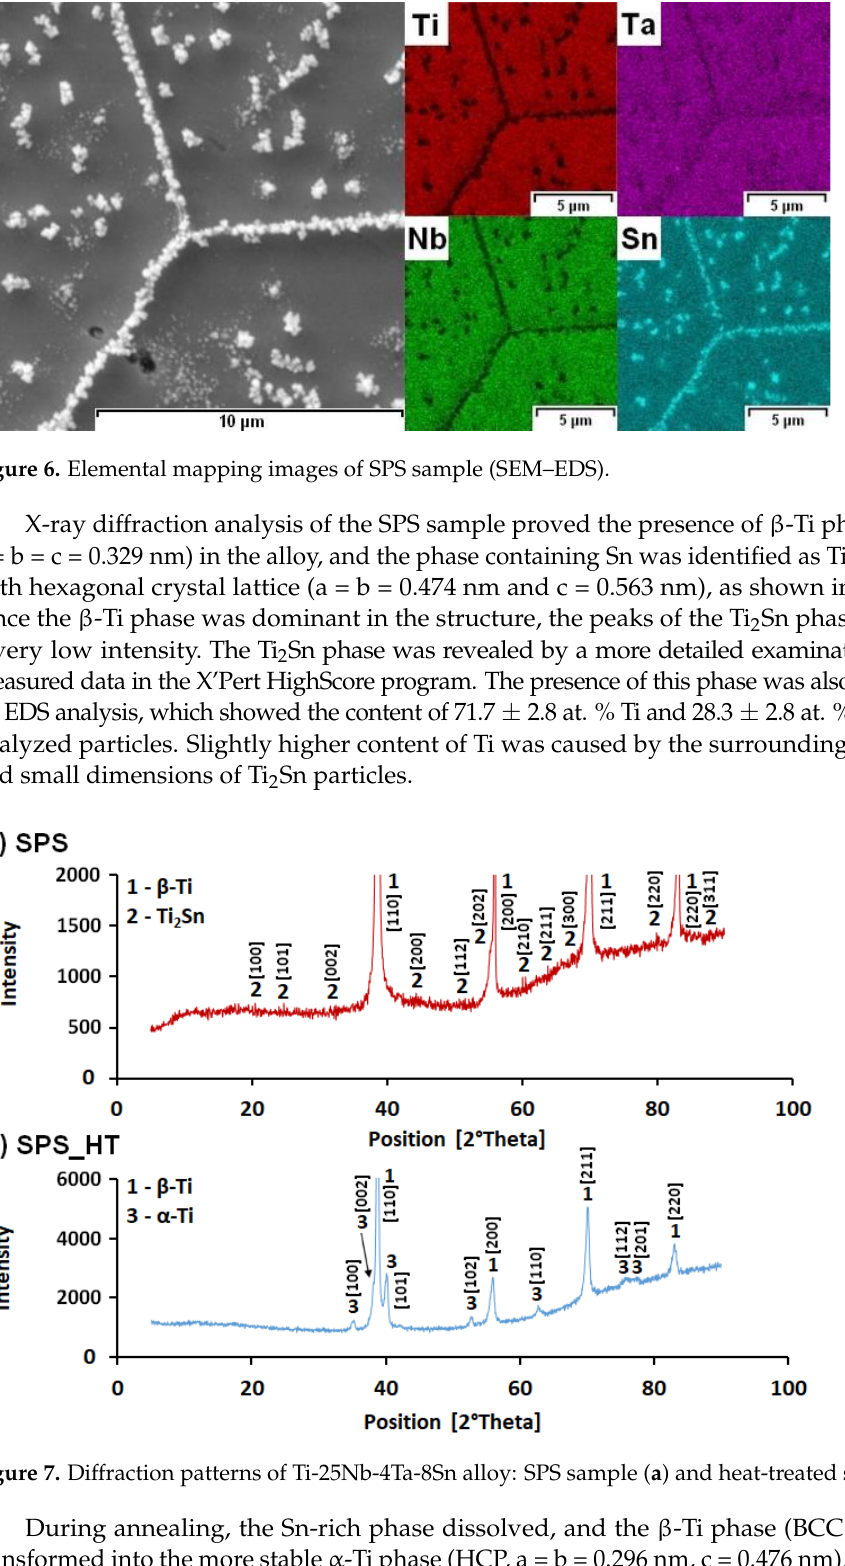
(Figure 8). Electron diffraction analysis proved that the needle-like phase wa s α -Ti, with